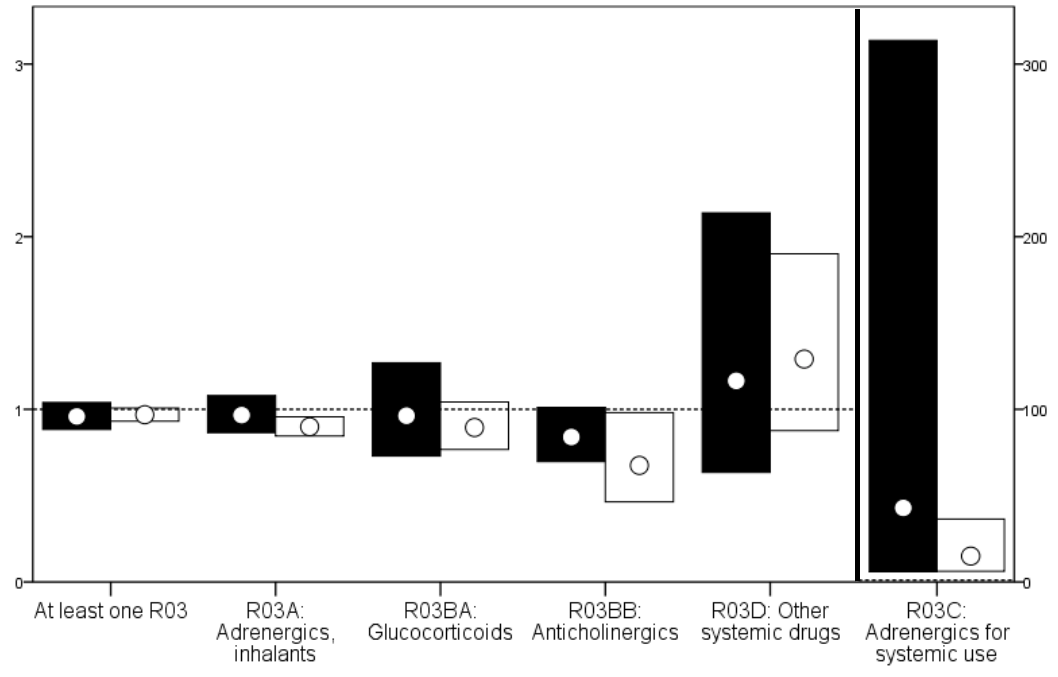
Figure 1. Relative risks with 95% confidence intervals for the prescription of drugs among people with COPD (black) and asthma (white).